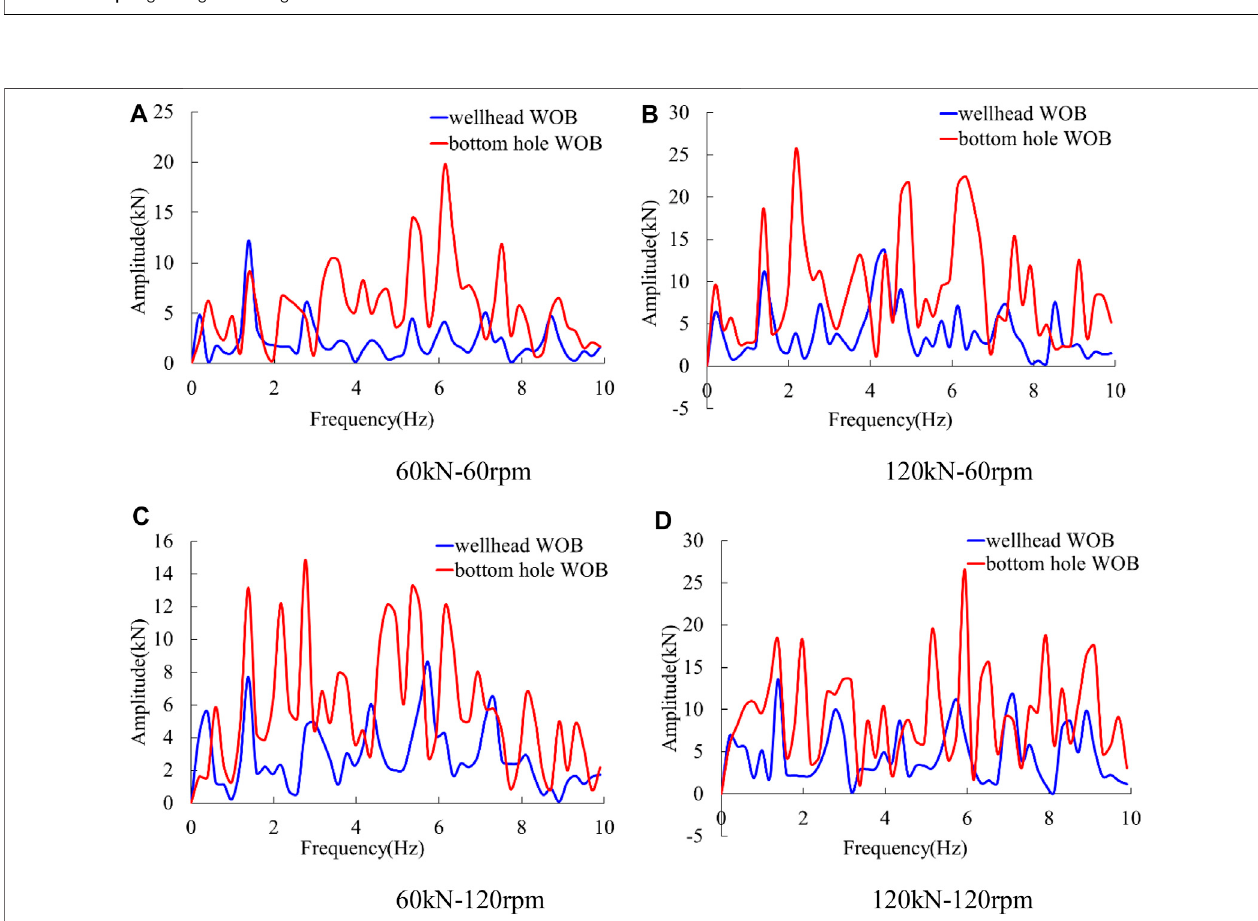
FIGURE 15 | Frequency spectrums of wellhead WOB and bottom hole WOB. (A) 60 kN – 60 rpm (B) 120 kN – 60 rpm (C) 60 kN – 120 rpm (D) 120 kN – 120 rpm.